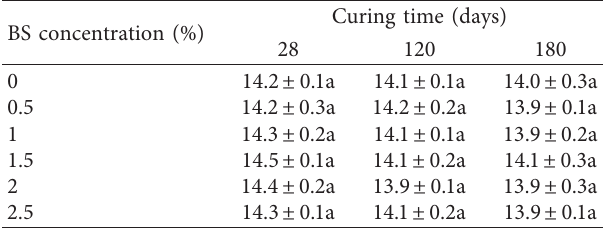
Table 4: Open porosity of mortars with different concentrations of biosurfactant (BS) at curing times of 28, 120, and 180